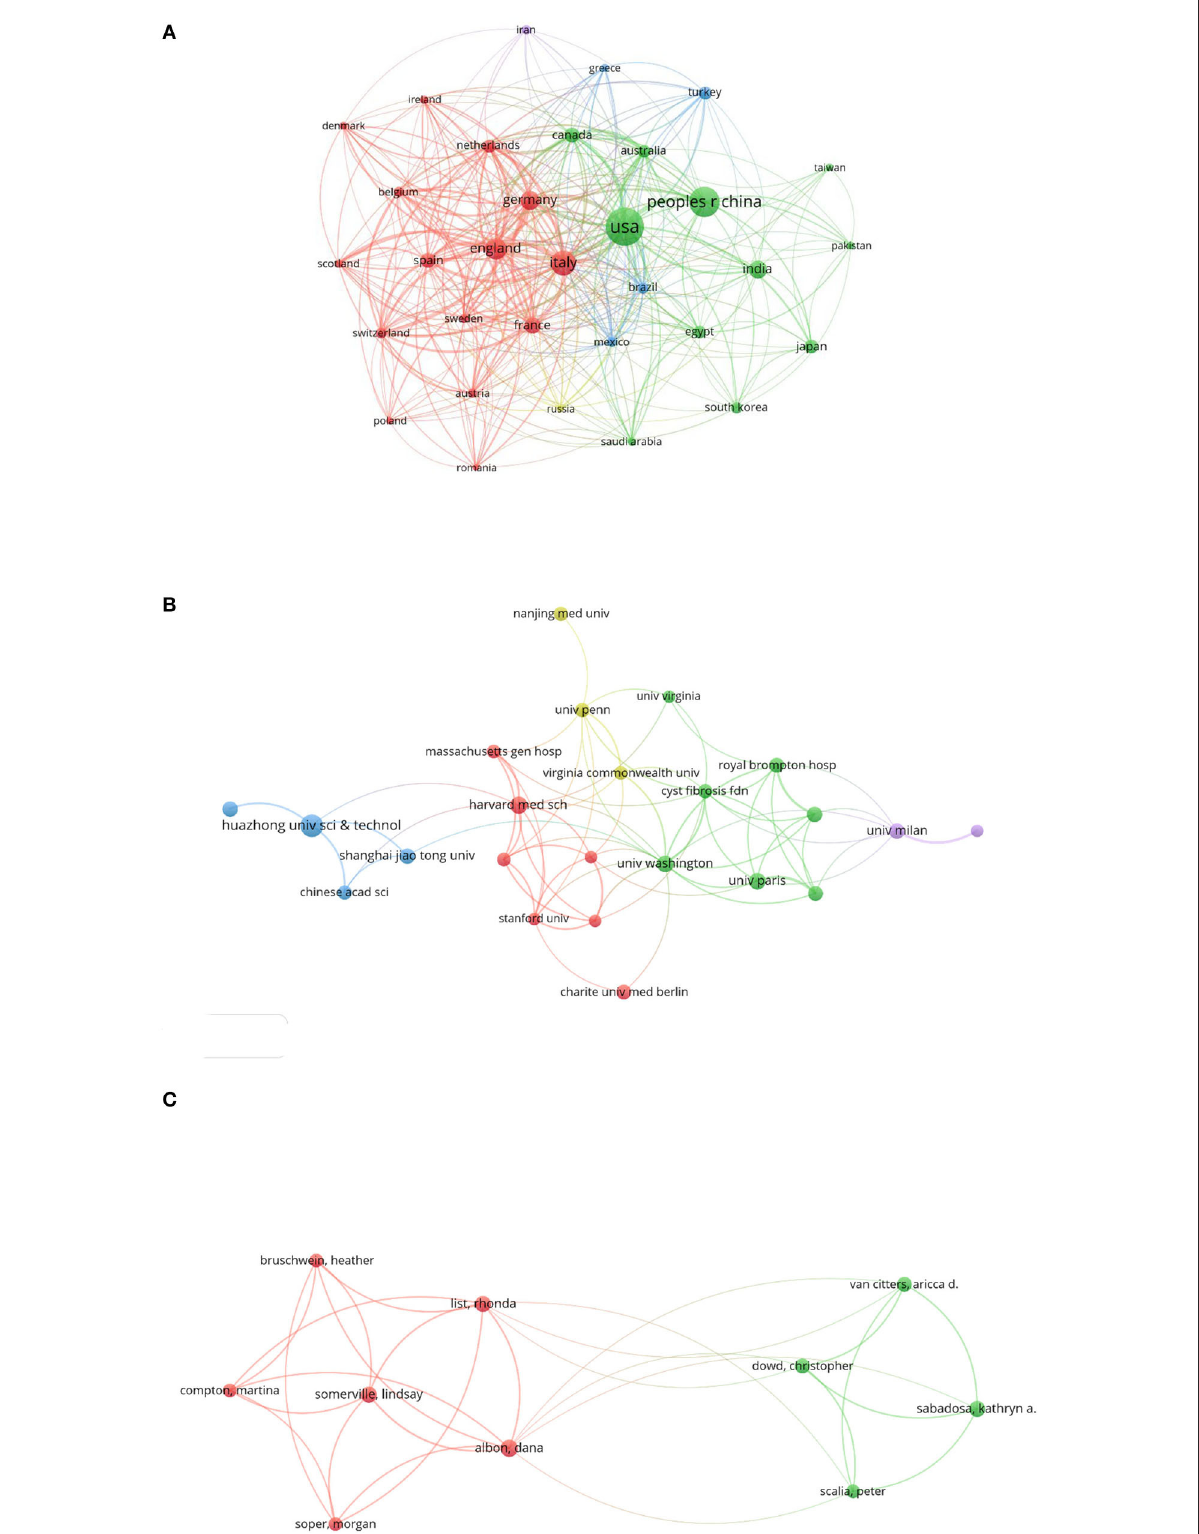
FIGURE4 Collaborations in the field of COVID-19 associated fibrosis. (A) Country/region-wise co-authorship. (B) Institution-wise co-authorship. (C) Individualize co-authorship. Different colors indicated distinguished clusters. The size of the bubble indicated publication counts. The thickness of the line indicated linkage